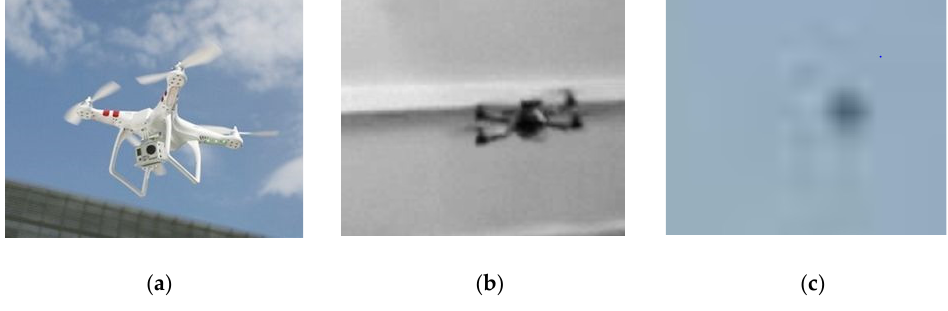
Figure 3. Example for each scale. ( a ) Detail scale. ( b ) Edge scale. ( c ) Block scale.